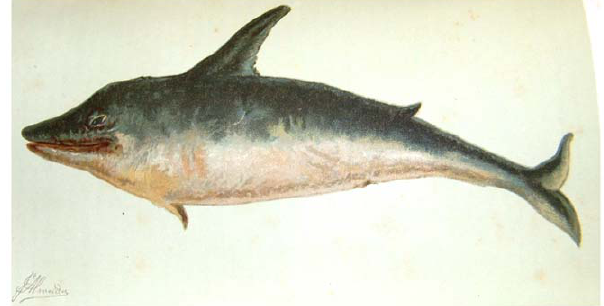
Figure 3. Drawing of a dolphin identified as Delphinusmaximus occurring in the Portuguese shores from Silva (1891); the same illustration could represent a bottlenose dolphin ( Tursiops truncatus ), a common dolphin ( Delphinus delphis ) or even a harbor porpoise ( Phocoenaphocoena ).